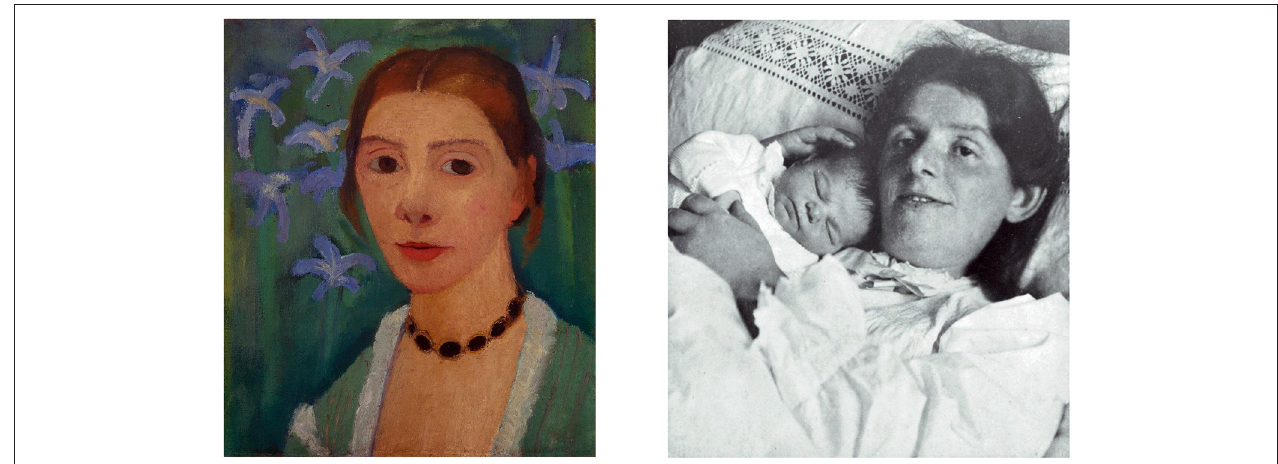
FIGURE 1 | Paula Becker (February 8, 1876–November 20, 1907), German painter, one of the most important representatives of early expressionism. Self-portrait and photography after giving